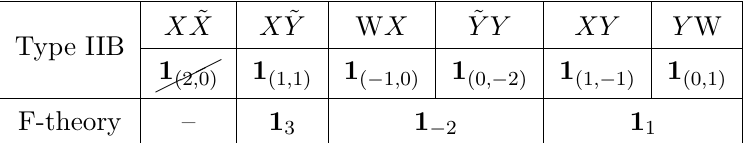
Table 13 . The matter arising at the di(cid:11)erent brane intersections and their recombination pattern in the F-theory model. Note that the singlet 1 is not present because the divisors X and ~ X (2 ; 0) only intersect on top of the orientifold